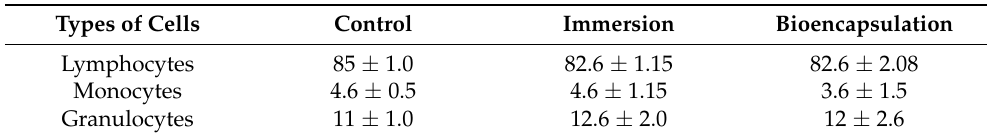
Table 1. Different leukocyte count of blood samples of all three group fishes (n = 3) at 14 days Table 1. Di ff erent leukocyte count of blood samples of all three group fi shes (n = 3) at 14 days post- vaccination.